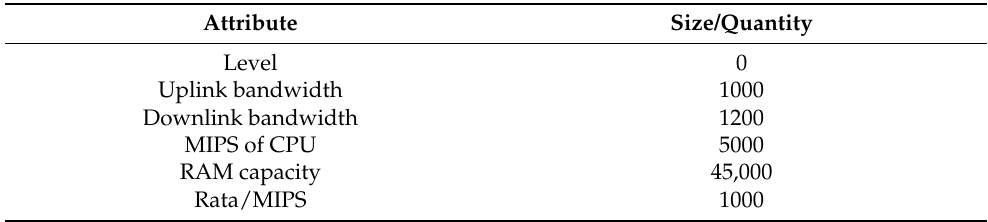
Table 4. FSB Characteristics.